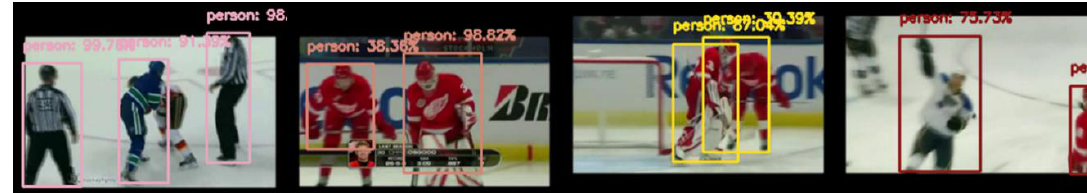
Figure 2. Persons detected in the frames of both classes from video clips of the hockey fight dataset using MobileNet-SSD.